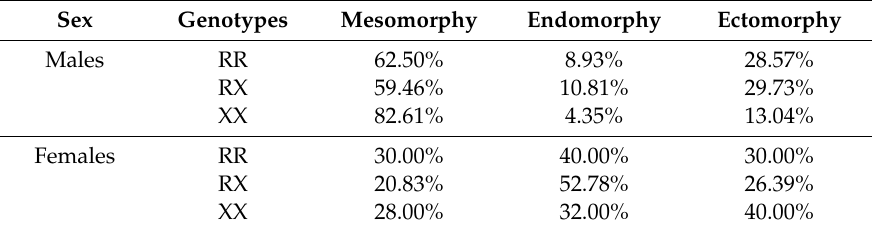
Table 3. Distribution of ACTN3 genotypes according to somatotype ( p = 0.37).